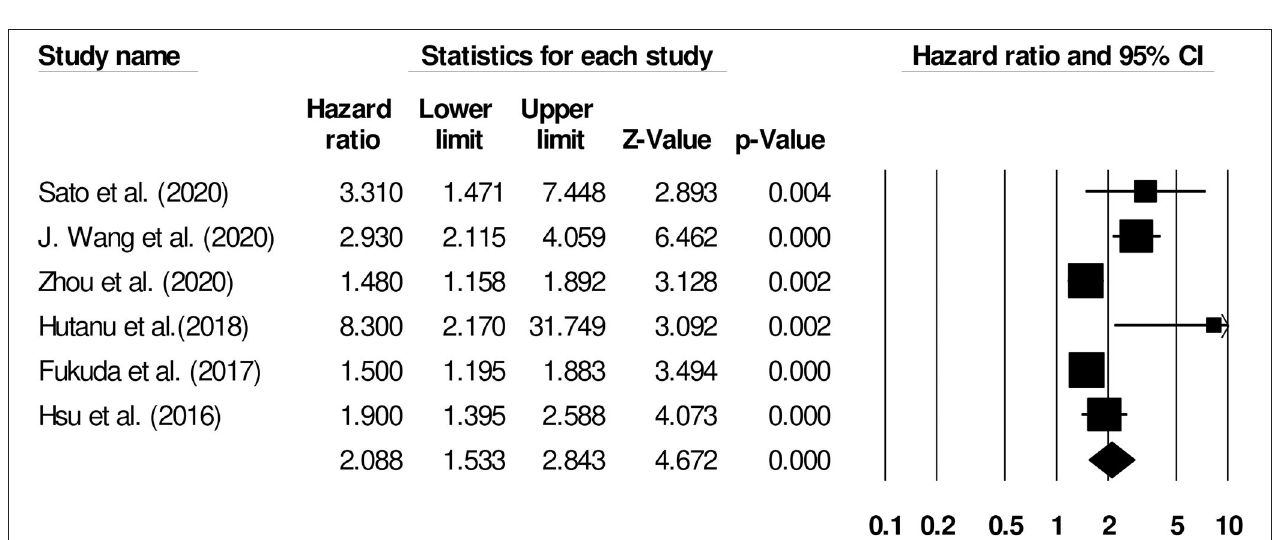
FIGURE 6 | Forest plot for studies evaluating the impact of D-dimer level on post-intracerebral hemorrhage functional outcomes. Hazard ratios are presented as black boxes while 95% confidence intervals are presented as whiskers. A small hazard ratio represents a lower influence of D-dimer levels on stroke patient functional outcome while a higher hazard ratio represents a higher influence.